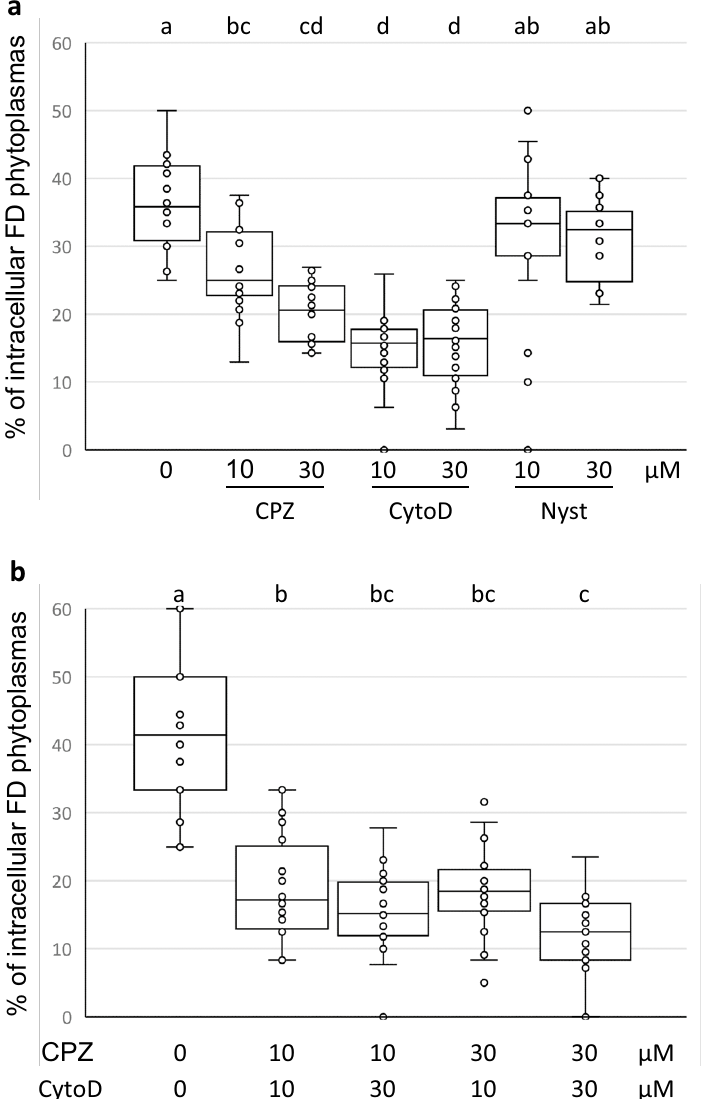
Figure 3. Internalization of FD phytoplasmas into S2 cells in presence of chlorpromazine (CPZ), cytochalasin D (CytoD) and nystatin (Nyst). Two concentrations (10 and 30 µM) were used for each inhibitor. Boxplots with different letters are significantly different under the ANOVA test of the R commander package of R software version 4.0.3 63 (https:// www.R- proje ct. org). The normal distribution of the value was previously verified using the Shapiro–Wilk normality test of R software (R commander